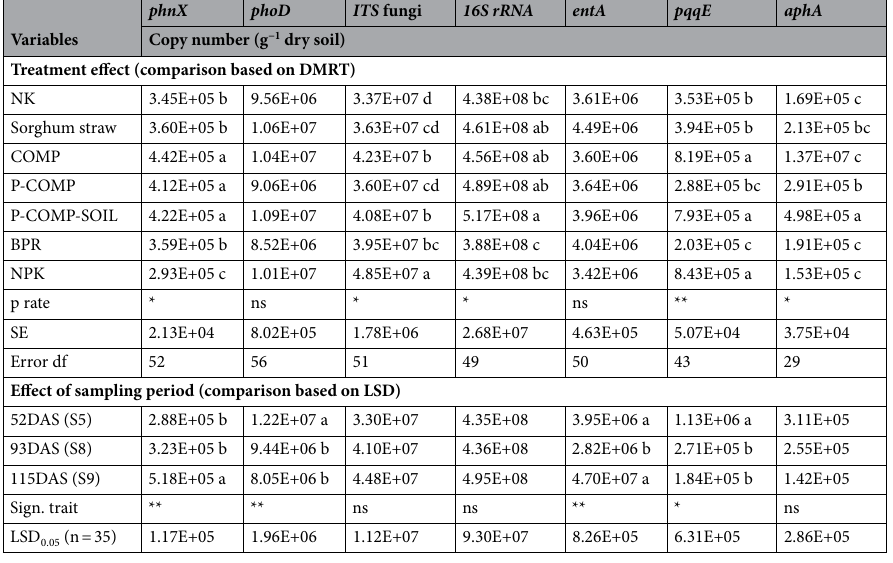
Table 5. Abundance of some microbial genes in the rhizosphere of sorghum. NK Without phosphate or compost addition, COMP Sorghum straw-based compost, P-COMP Sorghum straw-based compost + BPR, P-COMP-SOIL Compost made from sorghum straw, BPR, and sorghum rhizosphere soil, BPR Burkina phosphate rock, parameter values assigned by different letters differ significantly (**) at p < 0.01 and significantly (*) at p < 0.05, ns Not significant at p < 0.05. SE Standard error, error df Error degree of freedom, DMRT Duncan’s multiple range test, LSD Least significant difference, phnX Phosphatase, phoD Alkaline phosphatase, ITS Internal transcribed spacer (total fungi), 16S rRNA (total bacteria), entA Enterobactin- mediated siderophore, pqqE Pyrroloquinoline quinone, aphA Acid phosphatase , DAS Days after